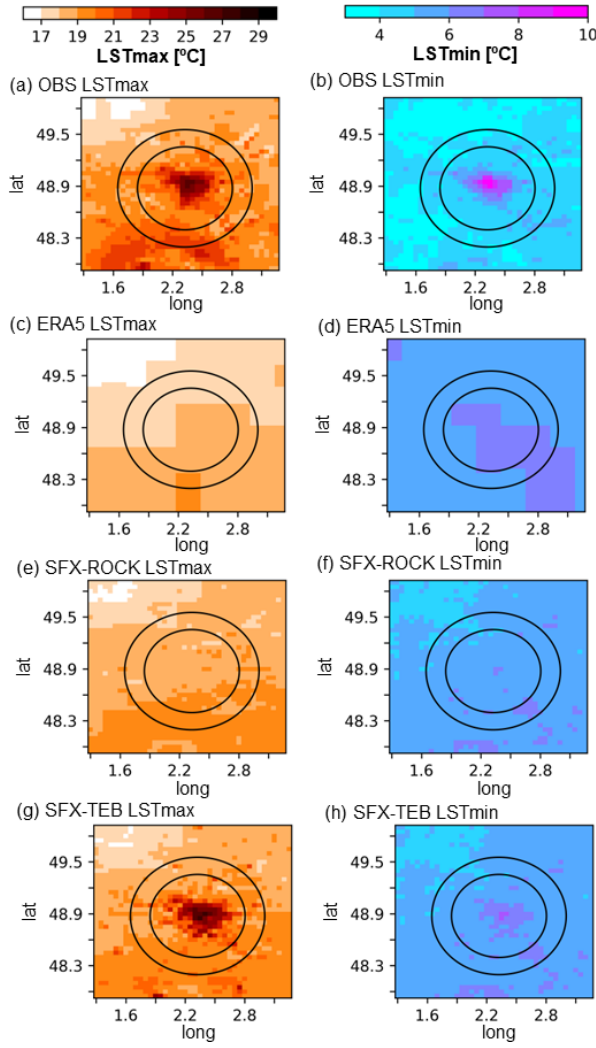
Figure 2. Maps of LST averaged over the 2004–2018 period dur- ing the daytime (left column) and nighttime (right column) over the study domain computed from LSA-SAF (a, b) , ERA5 (c, d) , SFX- ROCK (e, f) , and SFX-TEB (g, h) . The black circles represent the inner and outer rings of the SUHI computation, as previously de- scribed in Fig.